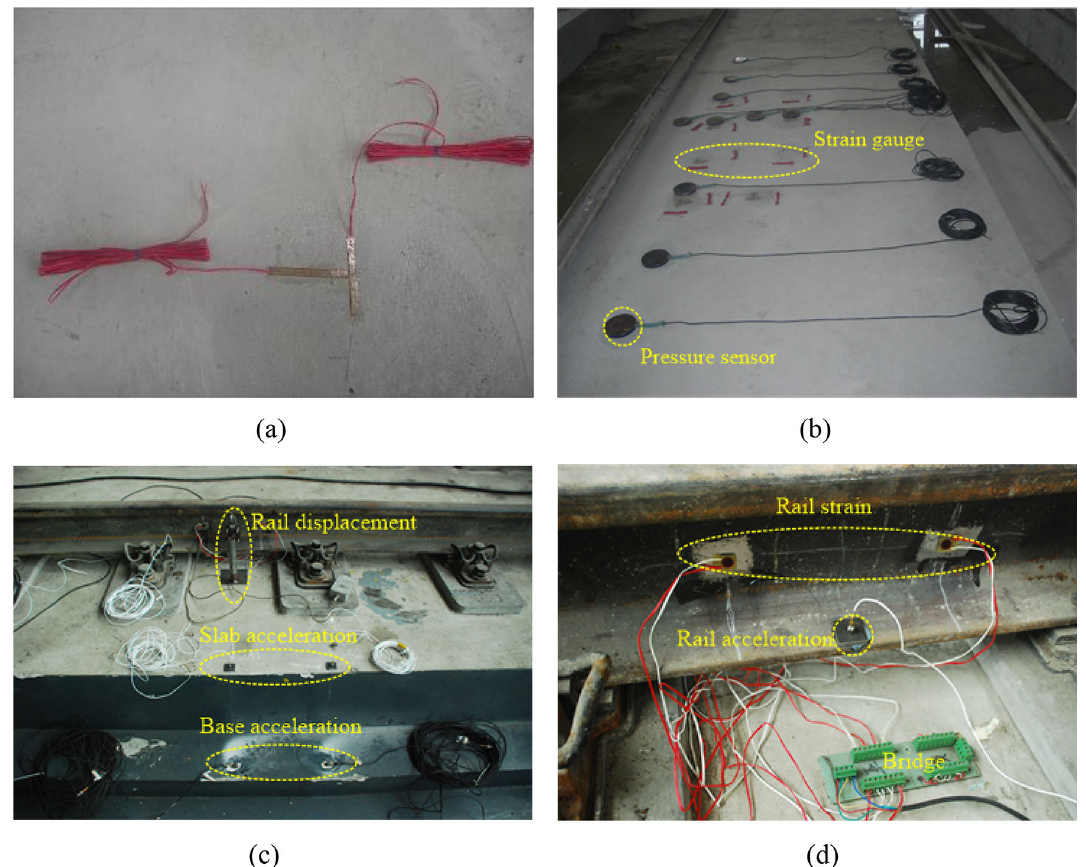
Fig. 11 Sensors layout process in ballastless track: a strain gauge on base surface; b sensor layout scheme on base surface; c sensors for track vibration; d sensors for rail deformation and vibration